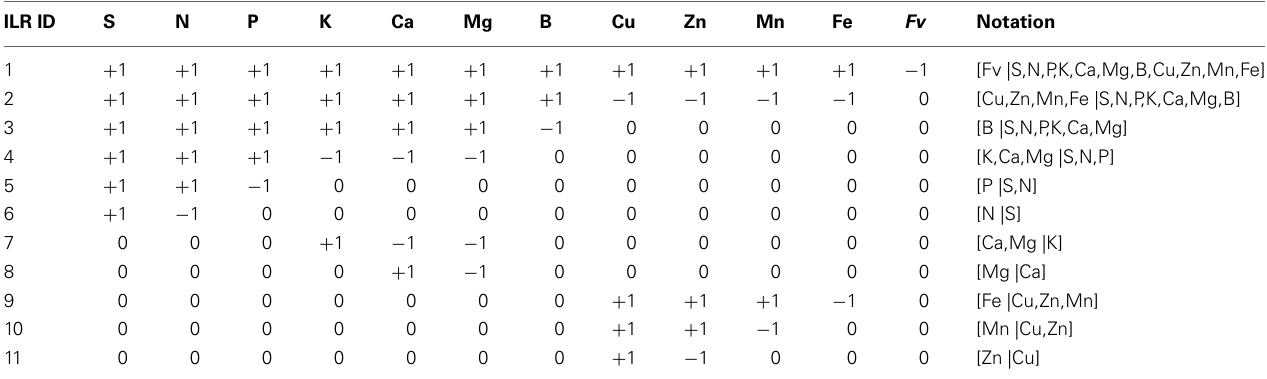
Table 1 | Sequential orthogonal partition of eleven nutrients of plant ionome and the filling value to compute 11 ilr orthonormal coordinates from concentration values and orthogonal